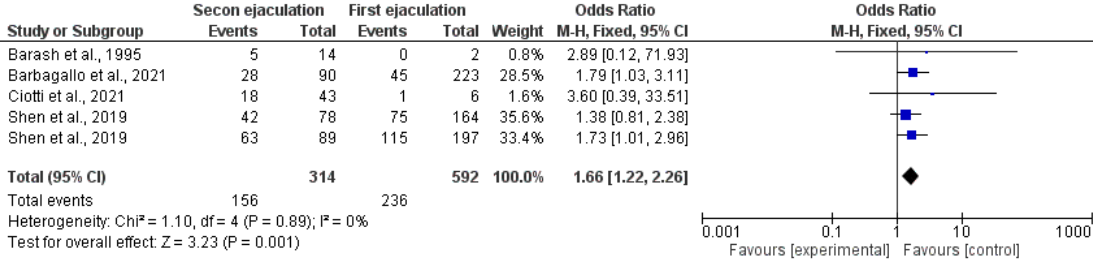
Figure 4. Forest plot showing the effects of a very short abstinence period on the clinical pregnancy rate.